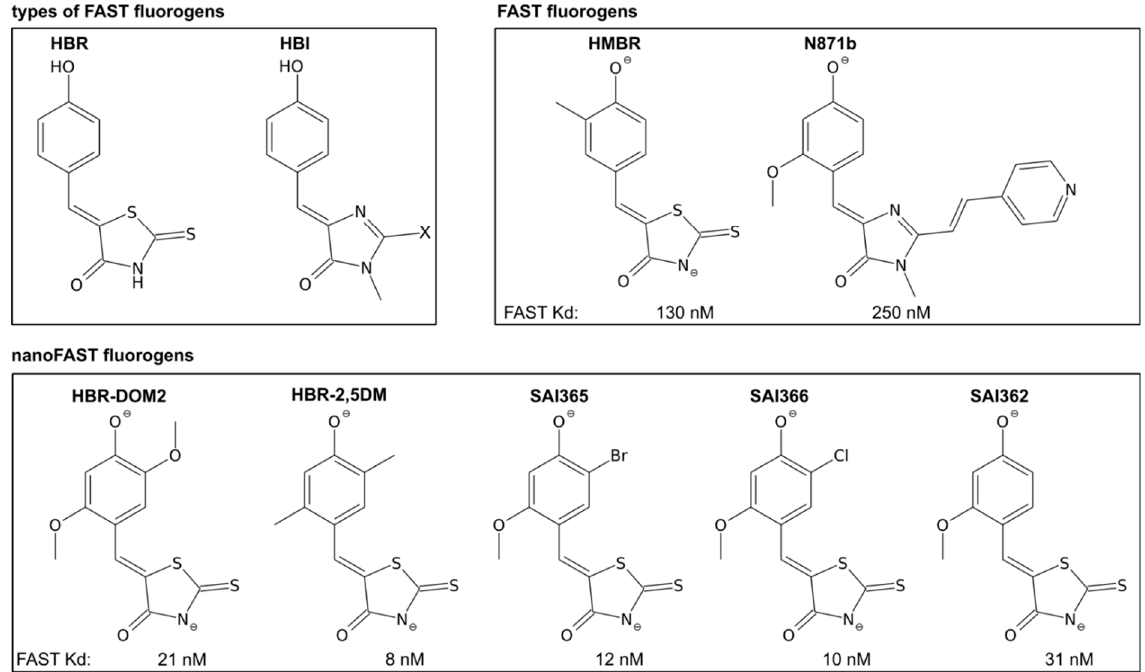
Figure 4. Structures of nanoFAST and FAST fluorogens. Dissociation constants of fluorogens with FAST are provided under the structures, according to the works [5] (HMBR and HBR-2,5DM), [11] (N871b and HBR-DOM2), and according to the current work (SAI362, SAI365, and SAI366).